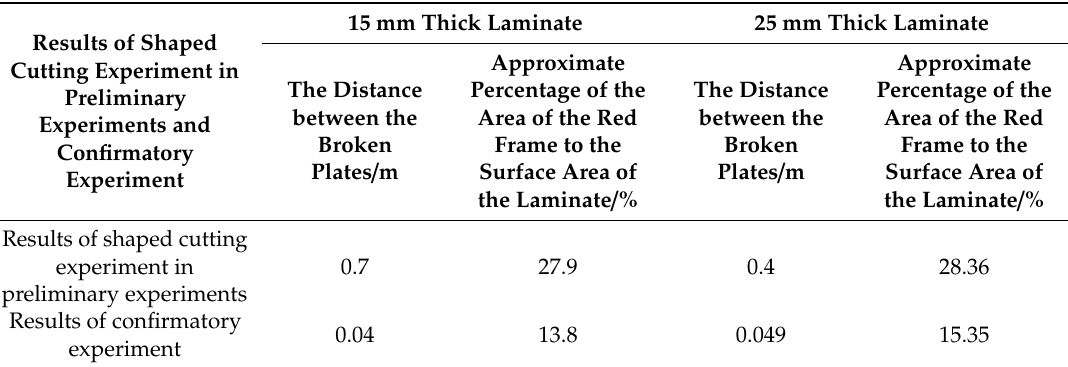
Figure 17. Schematic diagram of surface damage of laminated board. ( a ) 15 mm; ( b ) 25 mm. Table 6. Cut-off experimental data comparison.